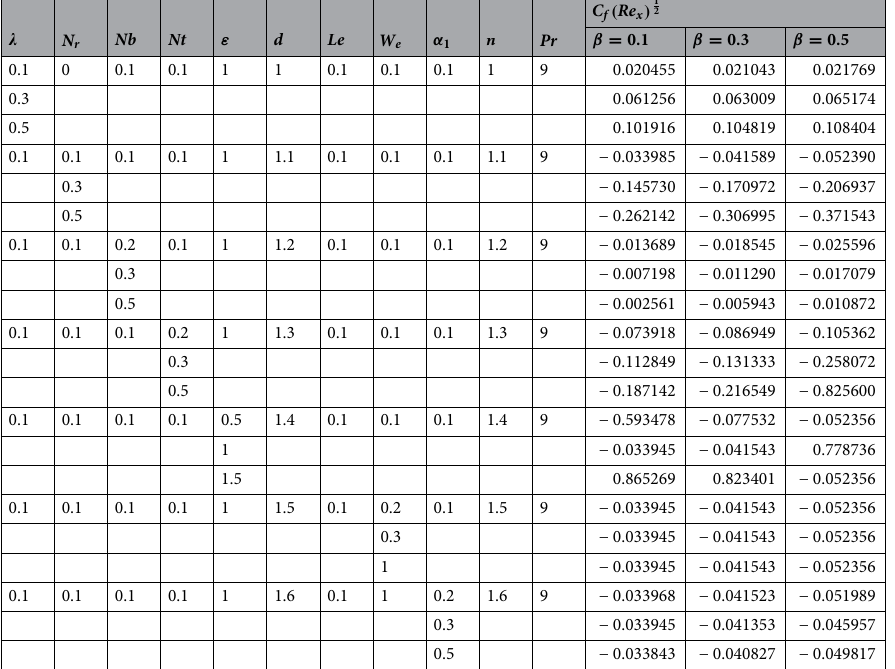
1 2 for distinct amounts of parameters.